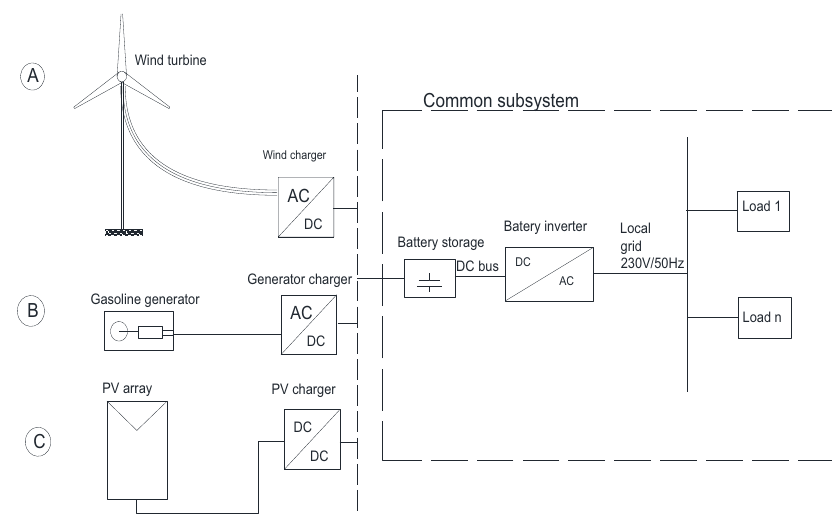
Fig. 5. Layout of a typical off-grid system.